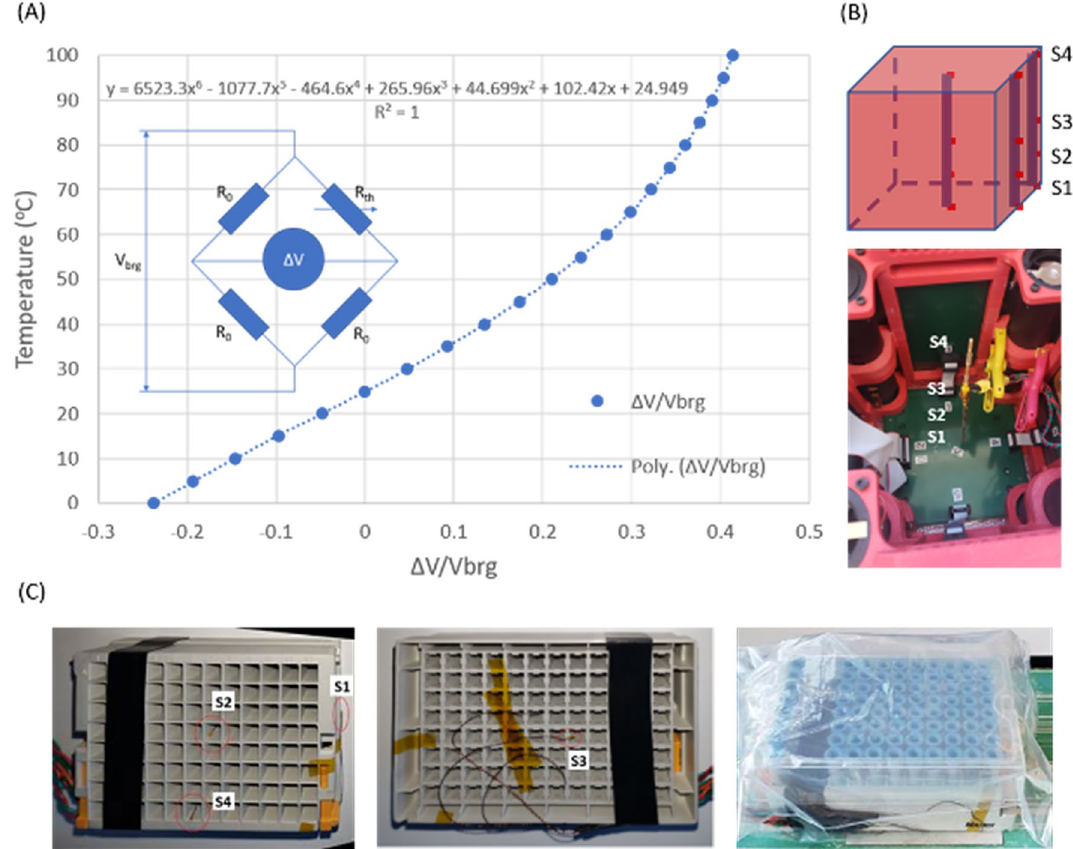
Figure 3. ( A ) Schematics of the Wheatstone bridge circuit; the T versus ∆V/Vbrg curve calculated using Eq. (1) and manufacturer’s thermistor resistance data was fitted by a sextic polynomial function with a R-Square value of 1; ( B ) schematics of the four wired thermistors on a stick to characterize the internal temperature of the µCRAIT box at the corner, side and center of the box; an image of the stick sensors measuring center temperature of the box is shown; ( C ) images showing the wired sensors to measure temperatures of the sample rack at different